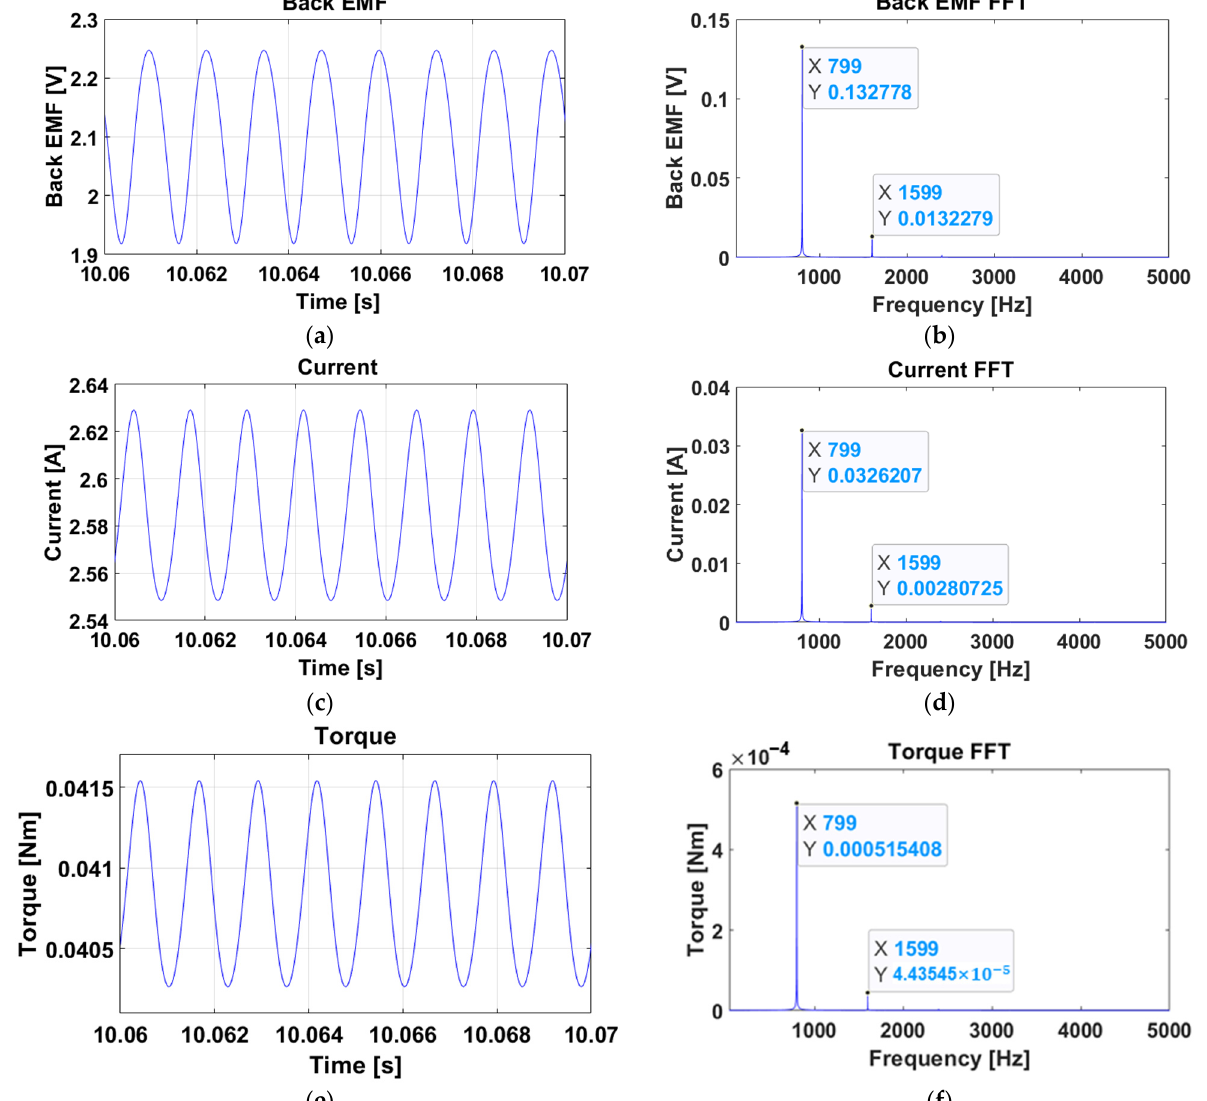
Figure 9. Results of simulation with back EMF including vibration in the CW: ( a ) Back EMF time data; ( b ) back EMF FFT data; ( c ) current time data; ( d ) current FFT data; ( e ) torque time data; ( f ) torque FFT data.